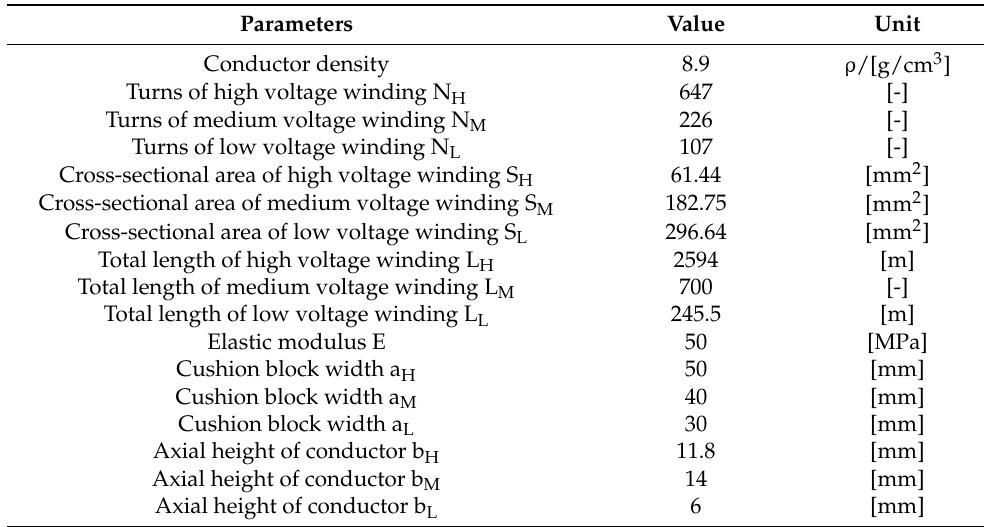
Table 2. Transformer